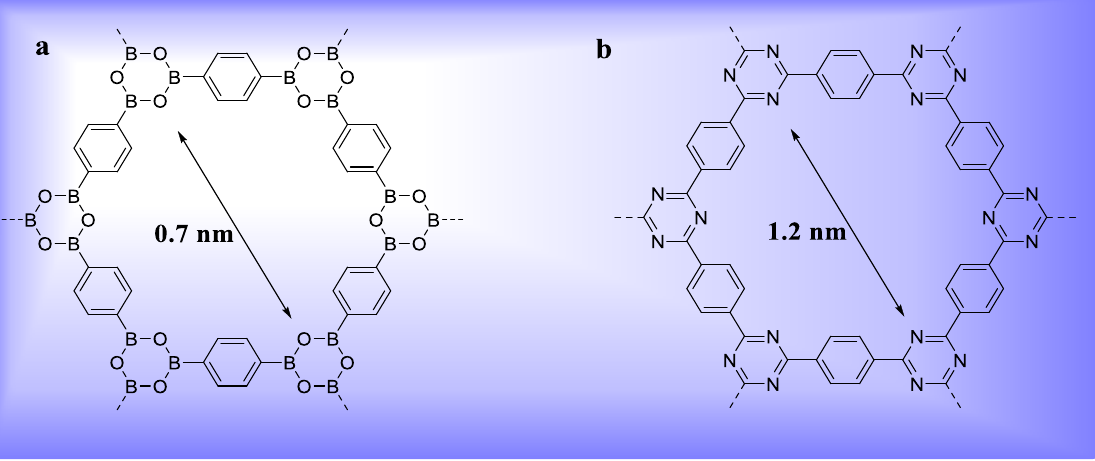
Figure 2. ( a ) Boron containing COF. ( b ) Triazine-based COF (CTF) [37] . “ "Used with permission of Royal Society of Chemistry, from [Covalent organic frameworks (COFs): From design to applica- Royal Society of Chemistry, from Covalent organic frameworks (COFs): From design to applications. tions. Ding, S.-Y.; Wang, W., Chem. Soc. Rev. 2013, 42, 548 – 568 in 2022; permission conveyed Ding, S.-Y.; Wang, W., Chem. Soc. Rev. 2013, 42, 548–568 in 2022; permission conveyed through through Copyright Clearance Center, Inc." Copyright Clearance Center,